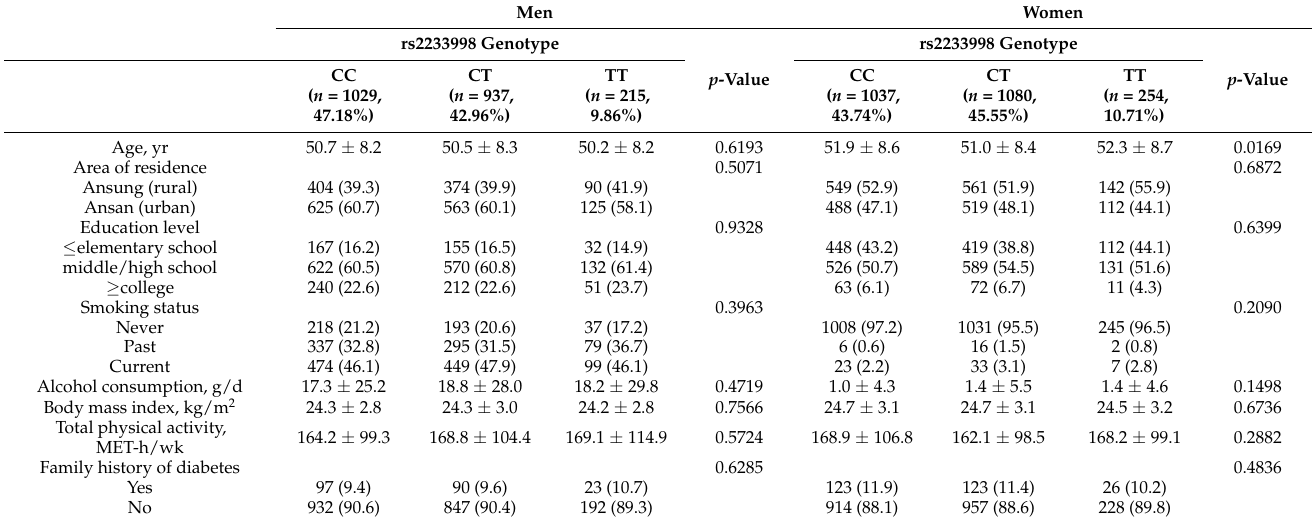
Table 1. General characteristics of the participants at baseline according to TAS2R4 rs2233998 genotype.